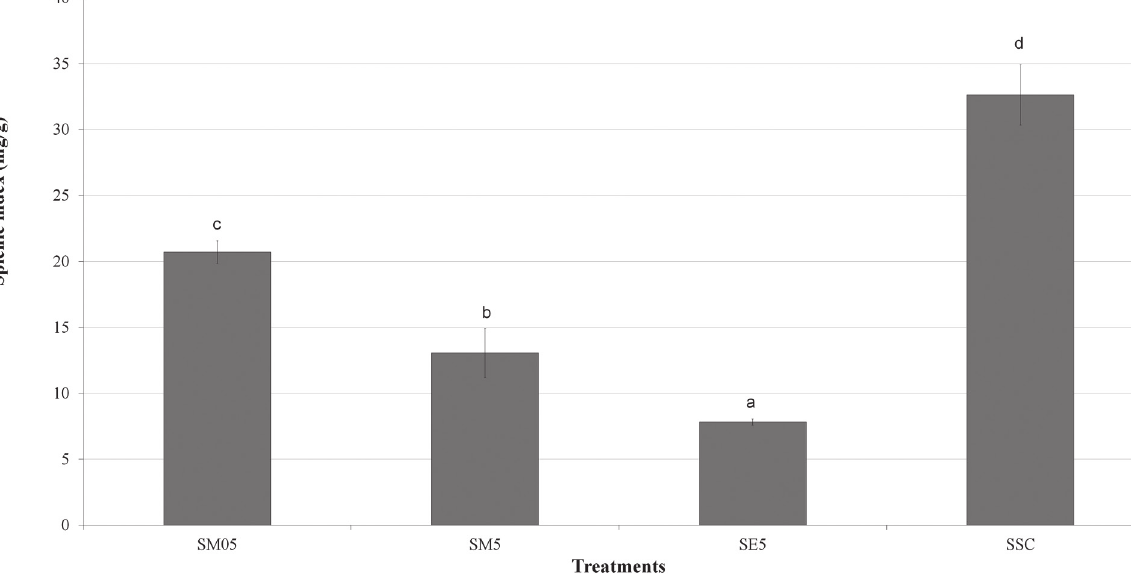
Figure 3 - Splenic index of female Swiss mice’s spleen implanted with sarcoma 180 according to treatments (Table I). Different letters show that the treatments statistically and significantly differed from each other according to Scott-Knott’s test (P ≤ 0.01).